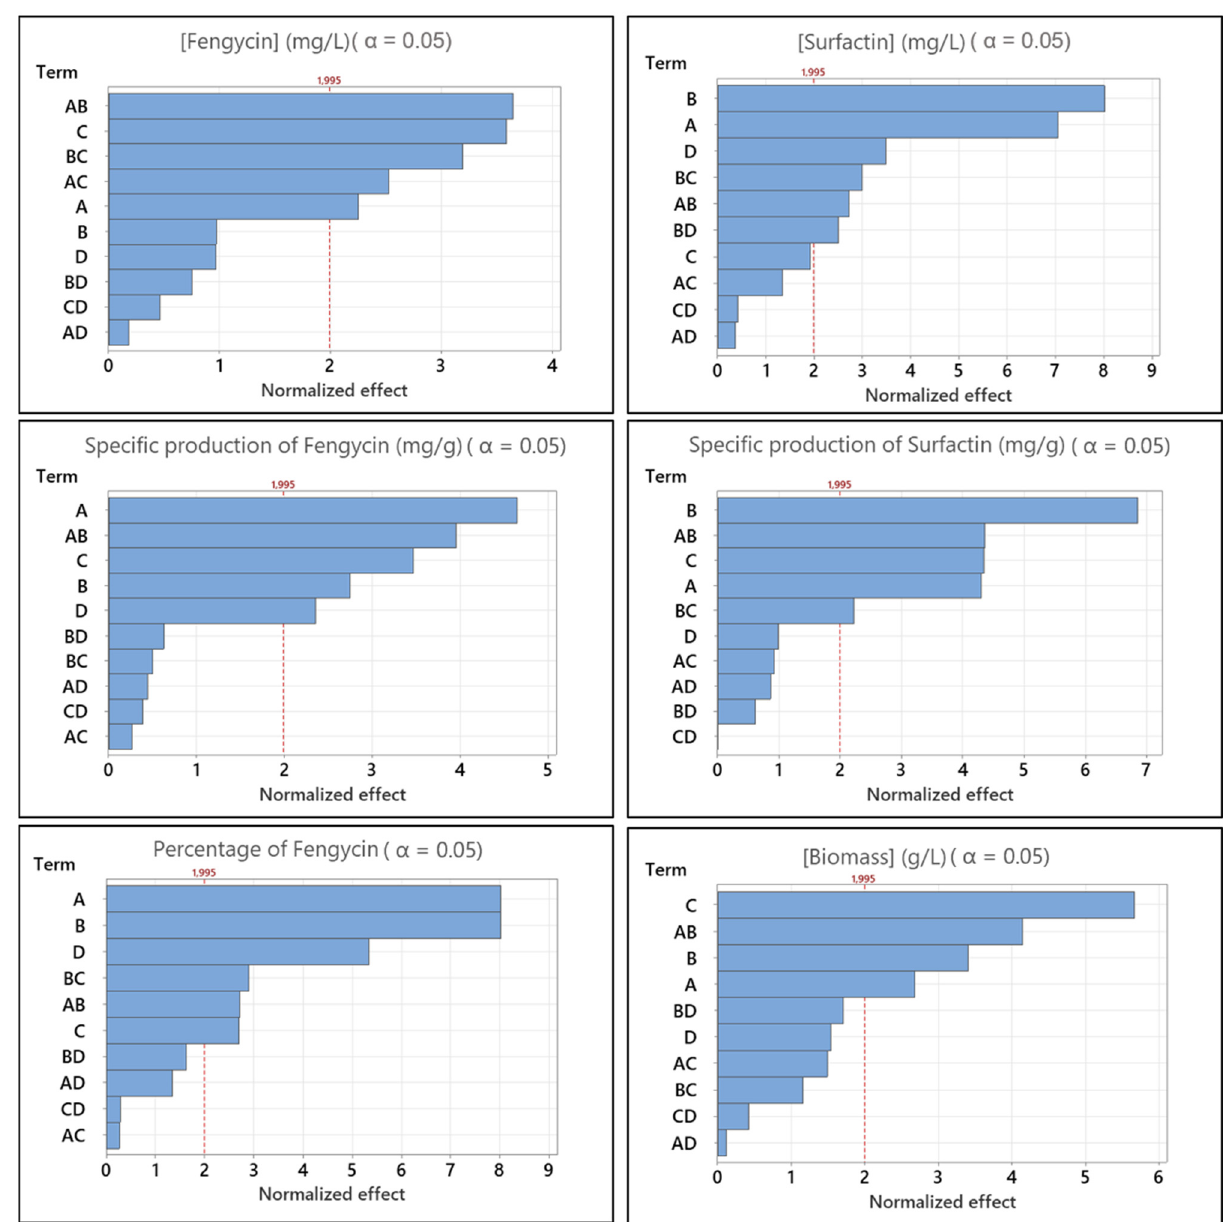
Figure 4. Pareto diagram of normalized effect for fengycin concentration, surfactin concentration, specific production of fengycin and specific production of surfactin, biomass production and percentage of fengycin produced in relation to total lipopeptides produced. A: carbon source; B: Nitrogen source; C: Phosphate concentration; D: K L a .